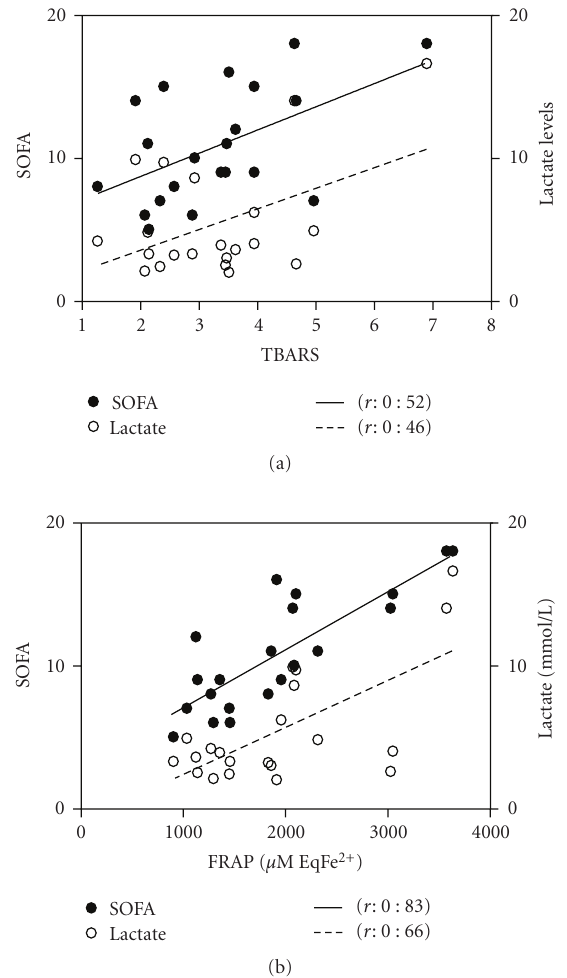
Figure 5: Evolution correlations of peak SOFA score and peak lactate levels with (a) peak TBARS levels and (b) peak FRAP levels. P < . 05 for all correlations